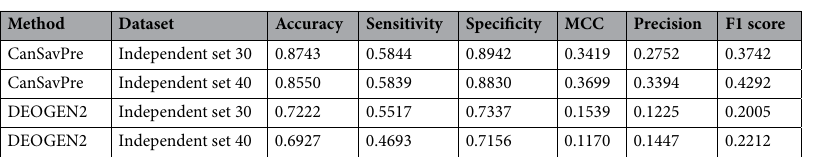
Table 8. Comparison of prediction performance values with DEOGEN2 in the independent